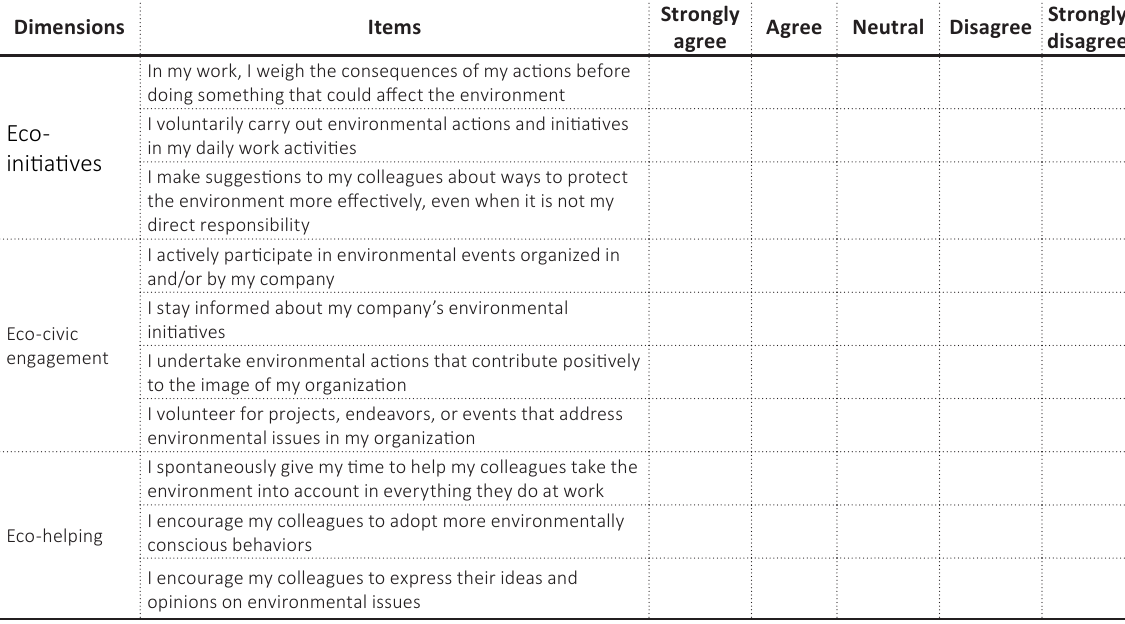
Strongly Agree agree